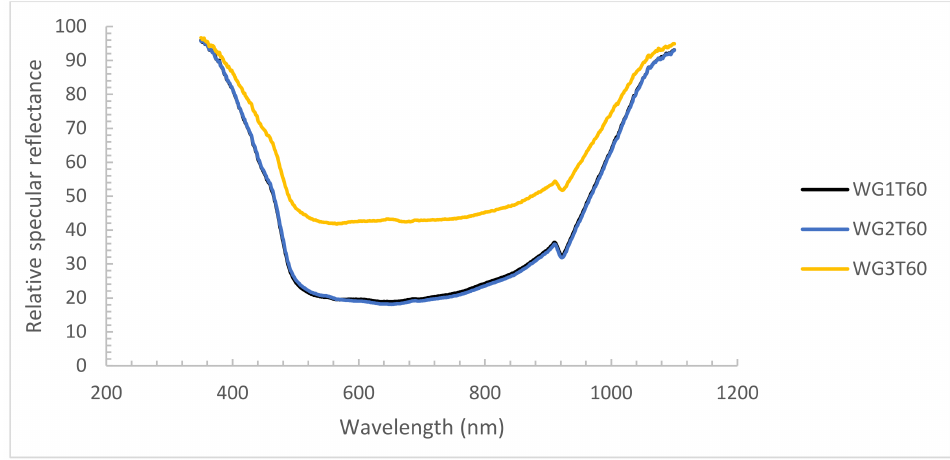
Figure 7. Specular light reflectance of the first set of specimens fired at 1000 ◦ C during 60